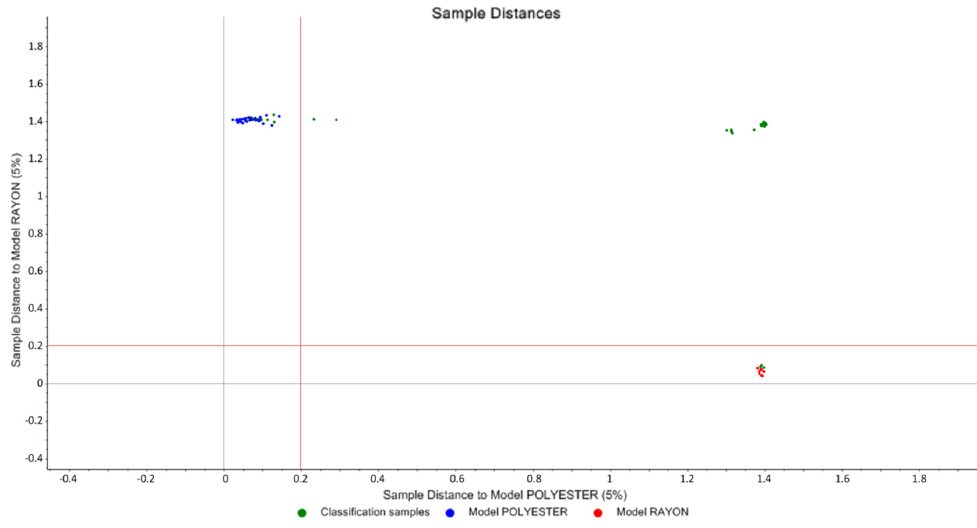
Figure 8. Polyester vs. rayon Cooman’s plot.